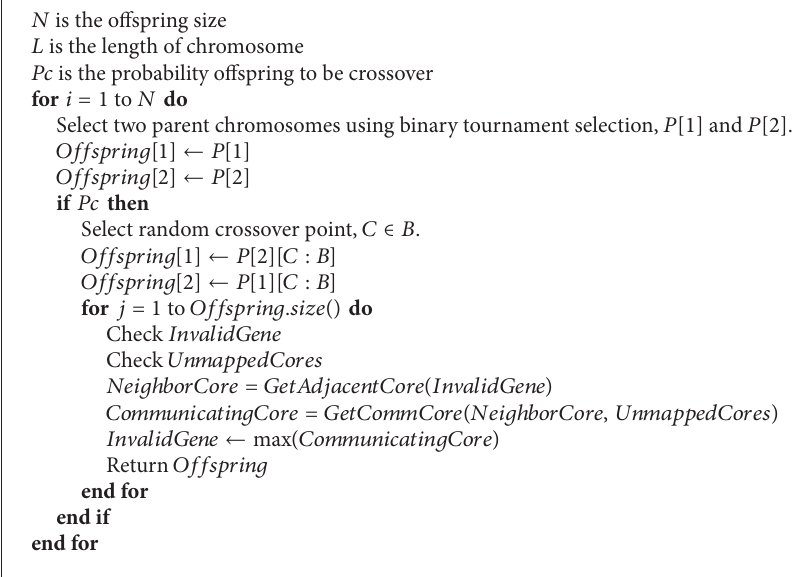
Algorithm 1: Knowledge-based (DK) crossover algorithm.